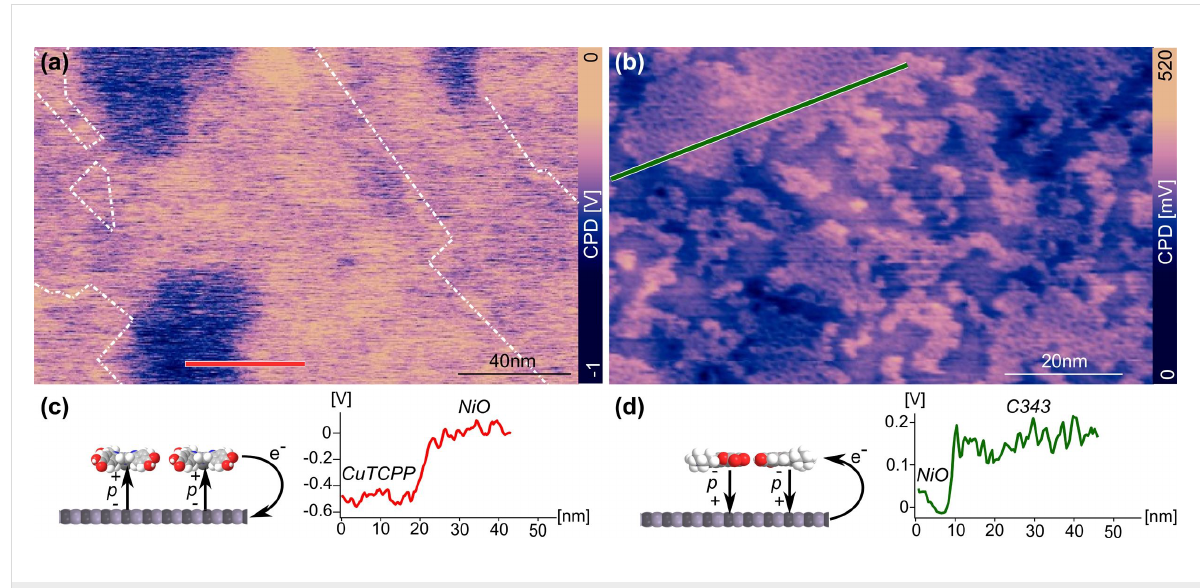
Figure 5: (a, b) CPD measurements of Cu-TCCP and C343 islands on the NiO(001) substrate, respectively (scan parameters: = 7 nm; Δ f 1 = − 7 Hz, V ac = 800 mV, and f ac = 1 kHz or f ac = 250 Hz, respectively). (c, d) Profiles recorded in (a) and (b), respectively, and models highlighting the direction of the dipole moment p and the corresponding charge